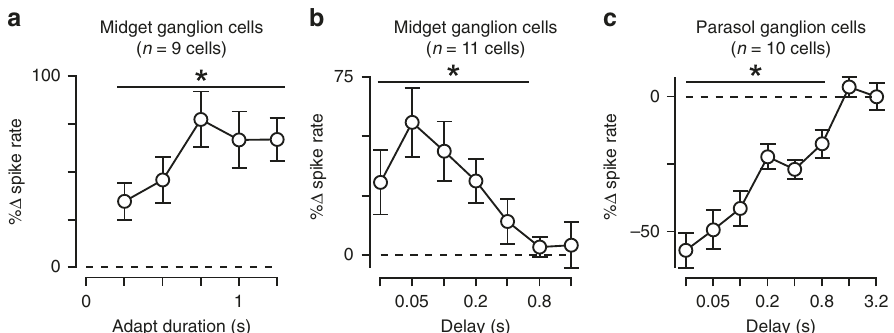
Fig. 3 Time course of contrast sensitization and adaptation. a Change in spike rate for the adapted condition relative to unadapted control for adaptation periods (contrast, ±0.25 – 0.5; delay 0.05 s). Adaptation period was varied between 0.25 and 1.25 s ( x -axis). The adapting stimulus produced a signi fi cant increase in spiking for each of the durations tested ( p < 4.0 × 10 – 3 ; n = 9 cells). b Duration of contrast sensitization in midget ganglion cells. Test fl ashes (contrast, ±0.25 – 0.5) were presented at different delays ( x -axis) following the offset of an adapting stimulus. Percent change in spike rate for the adapted condition relative to the unadapted condition is shown on the y -axis. Increase in spiking was statistically signi fi cant for delays ≤ 0.4 s ( p < 7.0 × 10 – 3 ; n = 11 cells). c Same as ( b ) for parasol ganglion cells. The adapting stimulus signi fi cantly reduced spiking at delays ≤ 0.8 s ( p < 7.0 × 10 – 3 ; n = 10 cells). Error bars indicate mean ± SEM. Statistical analyses were paired and signi fi cance was calculated using the Wilcoxon signed rank test